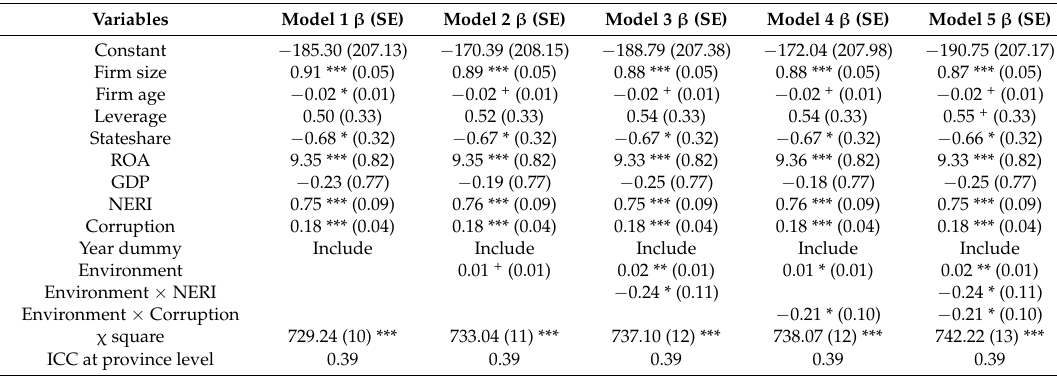
Table 3. Multilevel regression on corporate